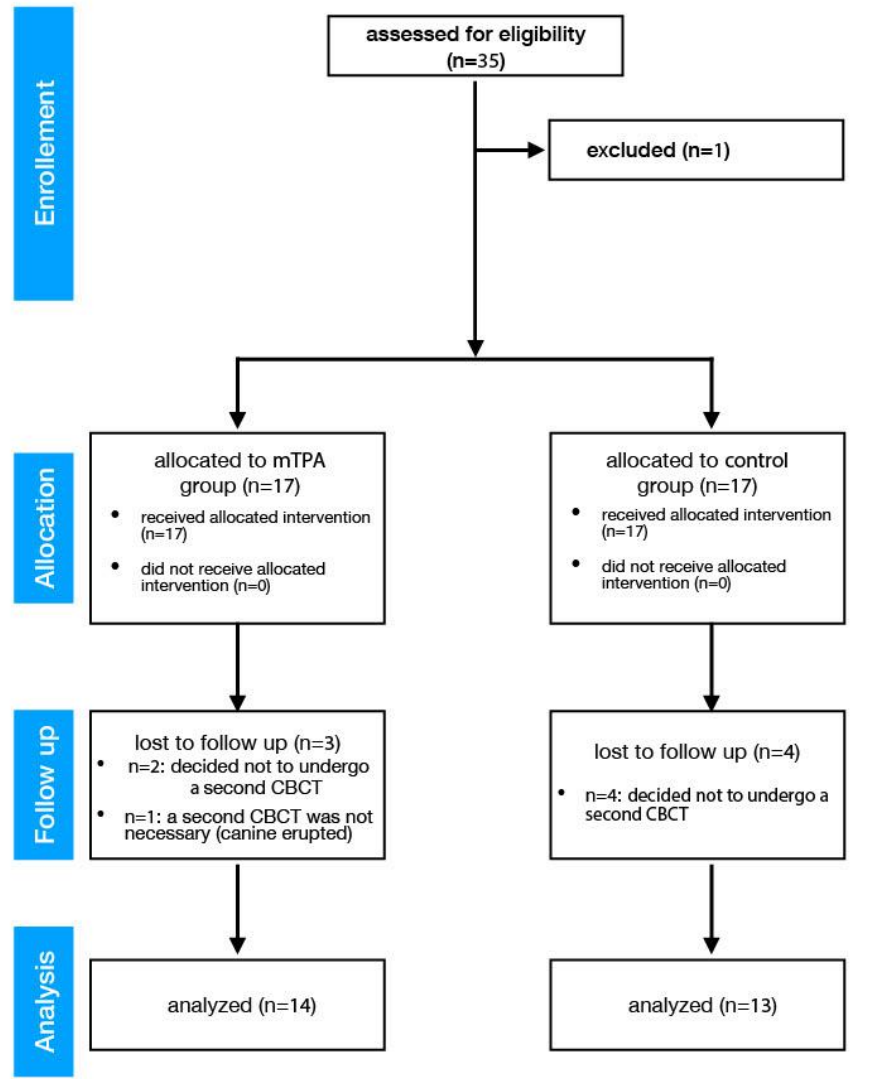
Figure 4. Flowchart of the study.